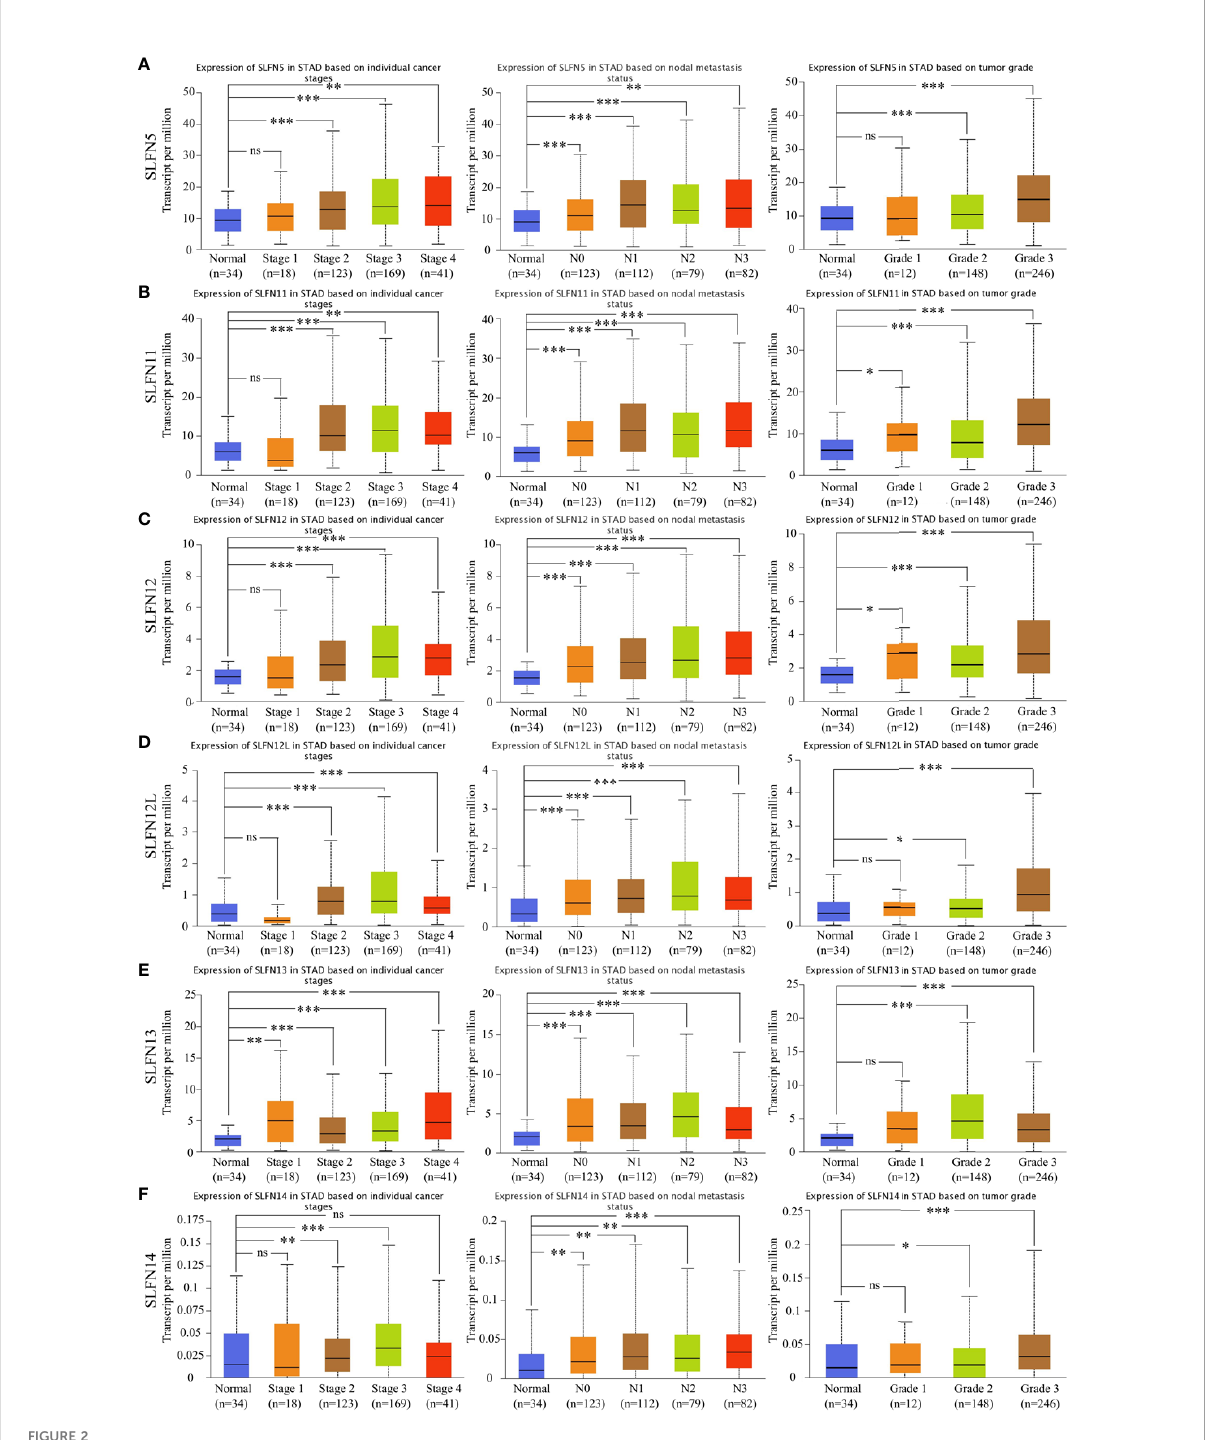
FIGURE 2 High expression of SLFN family members was correlated with gastric cancer stage, grade, and lymph node metastasis. (A-F) The mRNA expressions of SLFN5, SLFN11, SLFN12, SLFN12L, and SLFN13 were positively correlated with gastric cancer stage, tumor grade, and lymph node metastasis. *p < 0.05, **p < 0.01, and ***p < 0.001 and ns means no signi fi